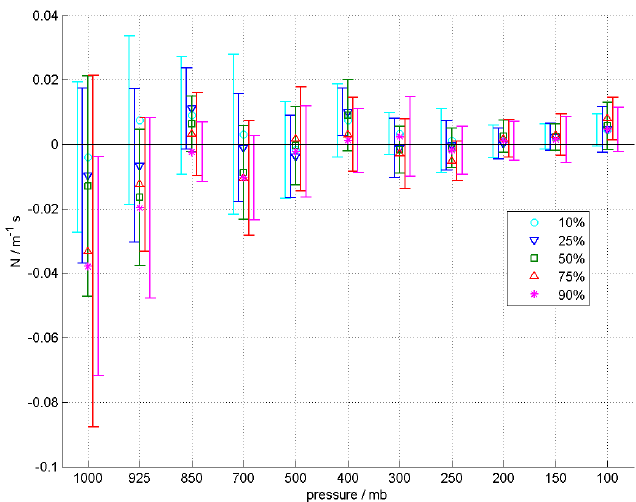
Figure 10. Results and vertical profile for the coefficient N at the five percentiles: 10%, 25%, 50%, 75%, and 90%. The error bars shown are for the 98% confidence interval.